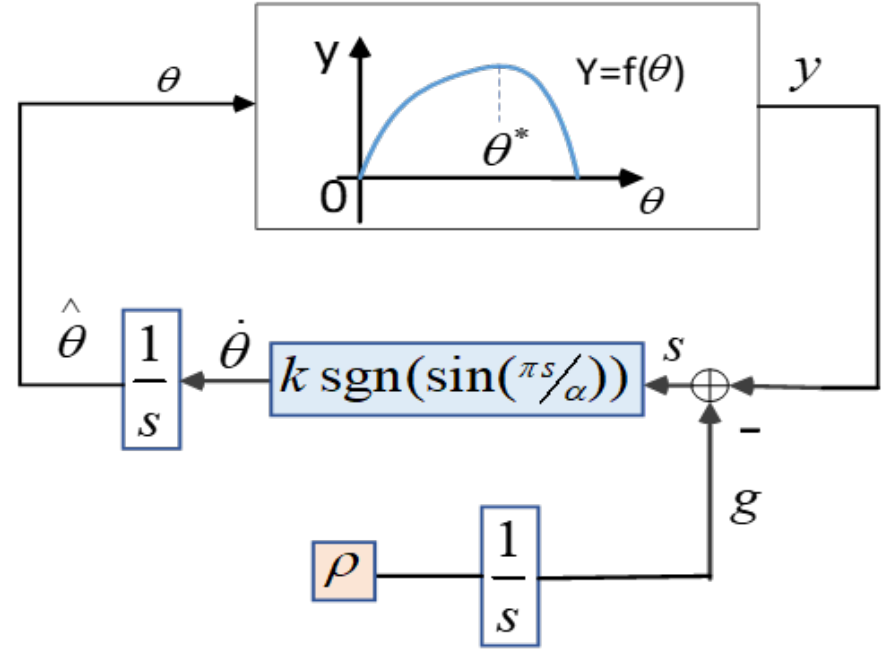
Figure 4. The Structure of the Sliding mode extremum-seeking control for dynamic systems.